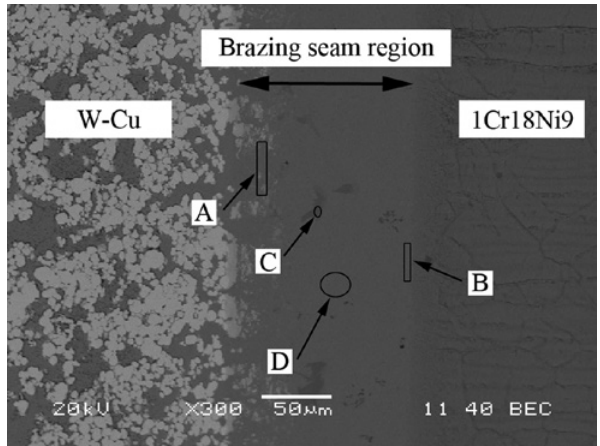
Figure 1: Microstructure and feature regions of the NiCrSiBFeTi brazed joint.